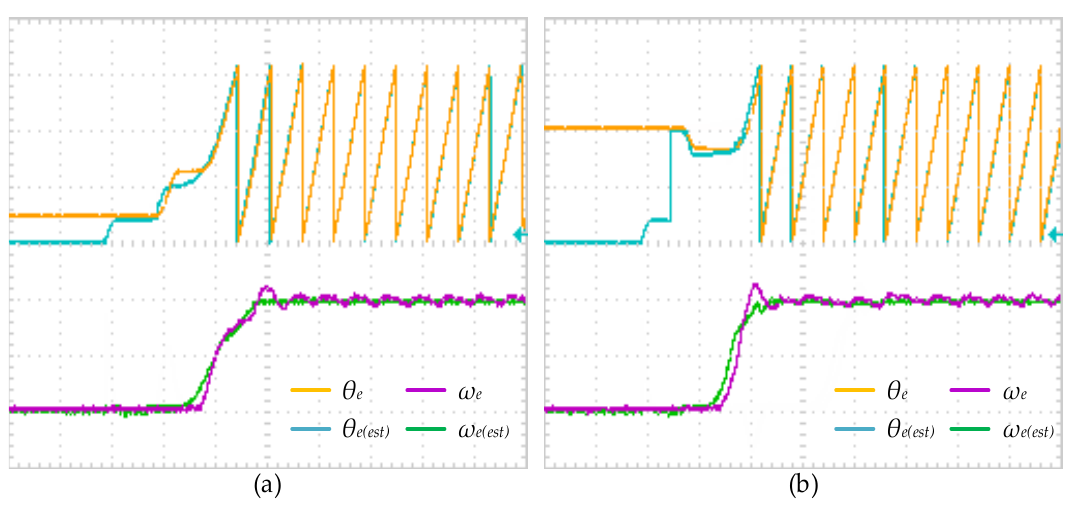
Figure 5. Waveforms of sensorless estimation at zero-low speed. (Initial rotor angle: ( a ) 1 rad; ( b ) 4 rad).